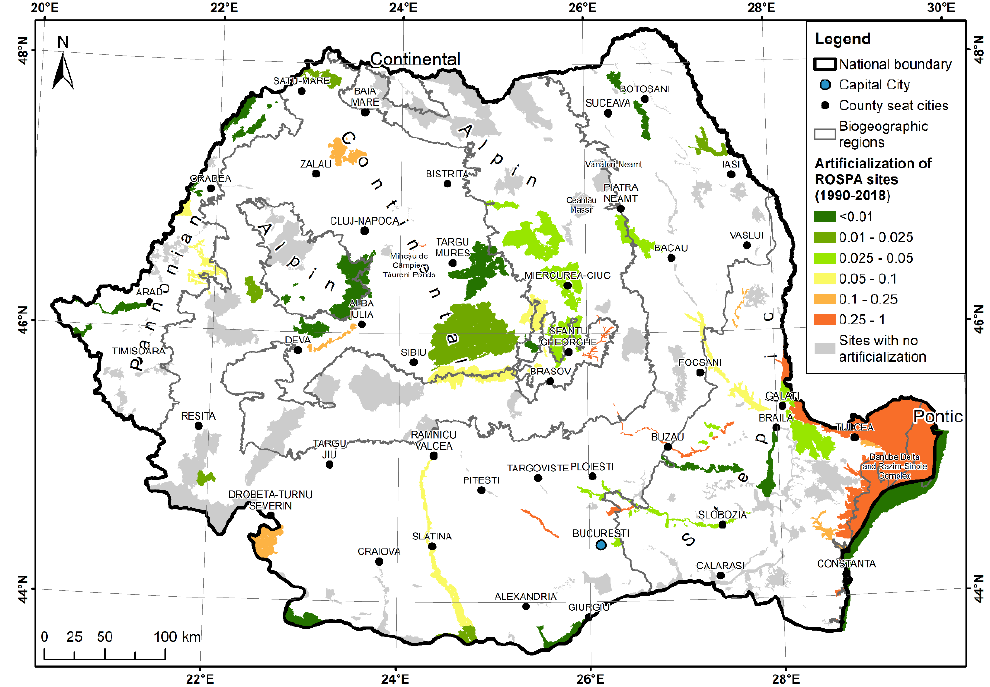
Figure 23. Percentage of artificialization in ROSPA sites.